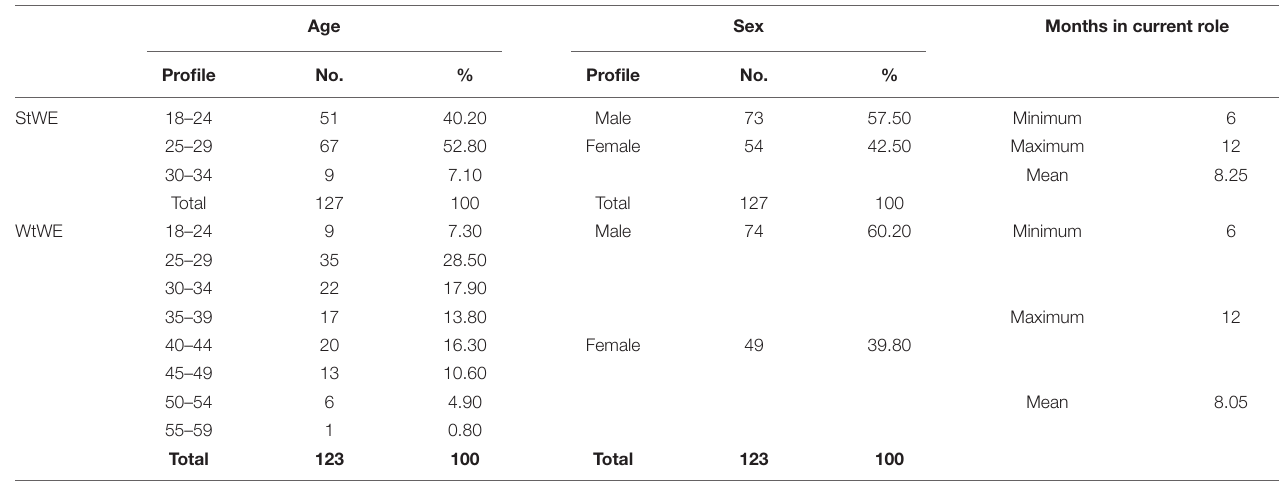
FIGURE 2 | Moderation interaction for study 1. TABLE 7 | Demographic characteristics (study